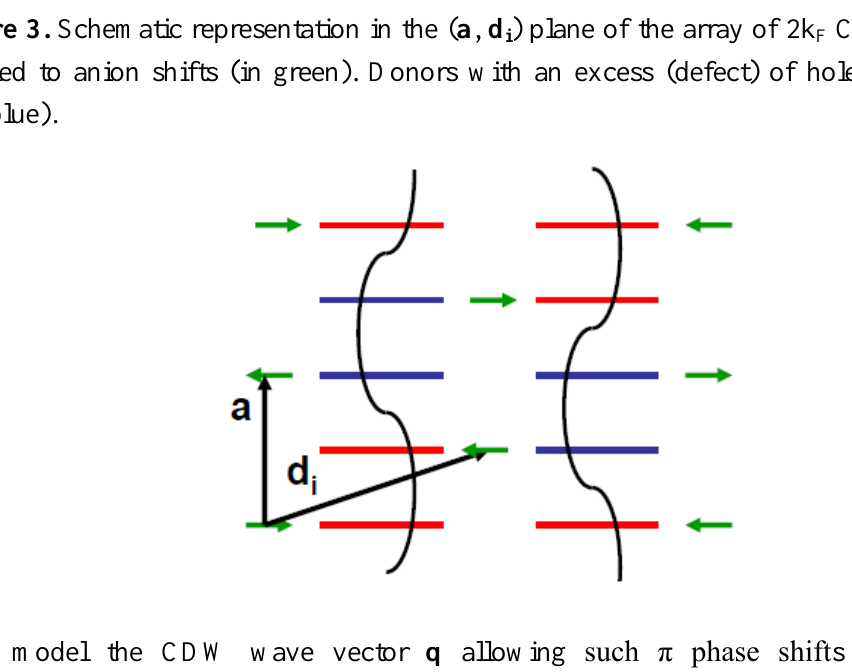
) plane of the array of 2k CDW (in black) i F